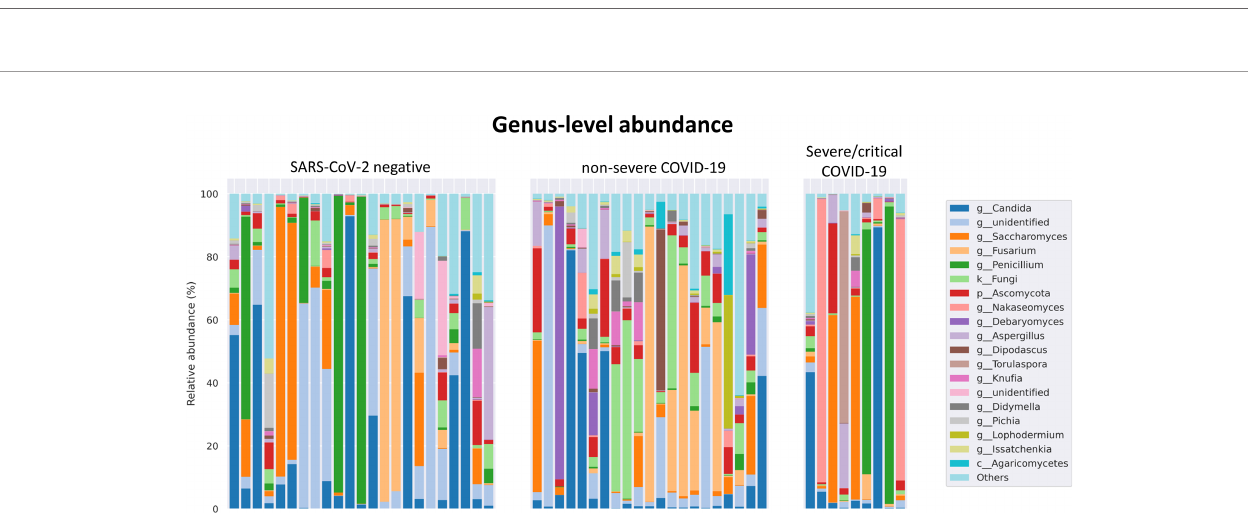
FIGURE 2 | Relative genus level abundance of 20 most abundant genera of the fungal gut microbiome in individual SARS-CoV-2 negative patients, patients with non-severe and severe/critical